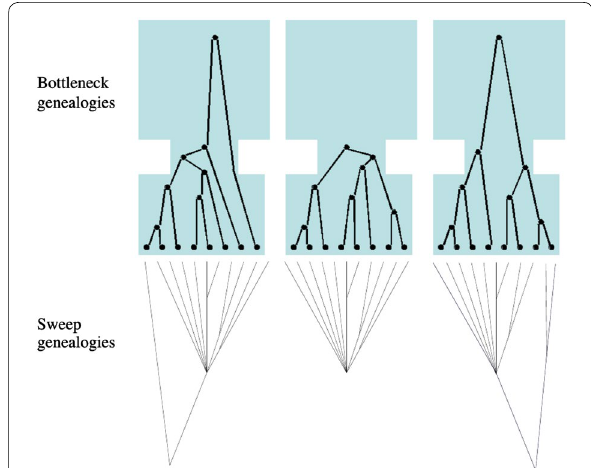
Fig. 3 Bottleneck demographic scenarios ( top panel ) may result in similar genealogies to a selective sweep ( bottom panel ). Both models may produce very short coalescent trees. As we move from the selec- tion site, selective sweeps produce genealogies with long internal branches. Similarly, bottlenecks may produce genealogies with very long internal branches if the ancestral population size is